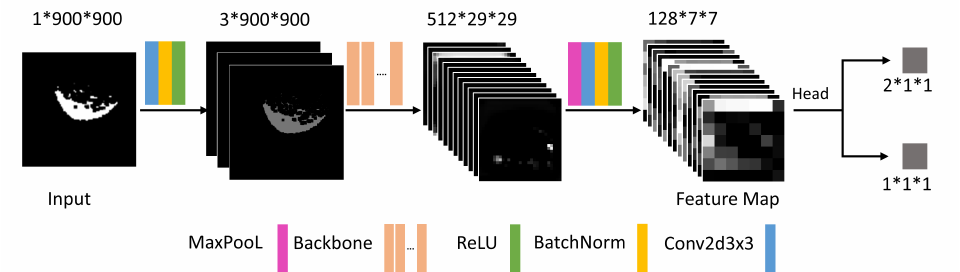
Figure 6. CNN was used to extract key information from the hedges.